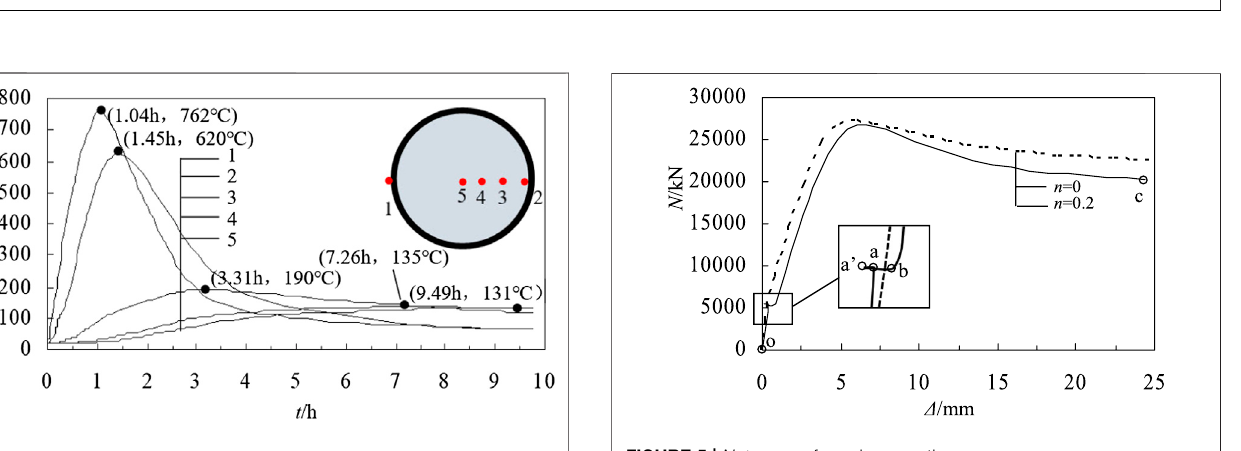
FIGURE 3 | Veri fi cation results. (A) Axial compressive performance at ambient temperature. (B) Fire resistence. (C) Axial compressive performance after fi re.